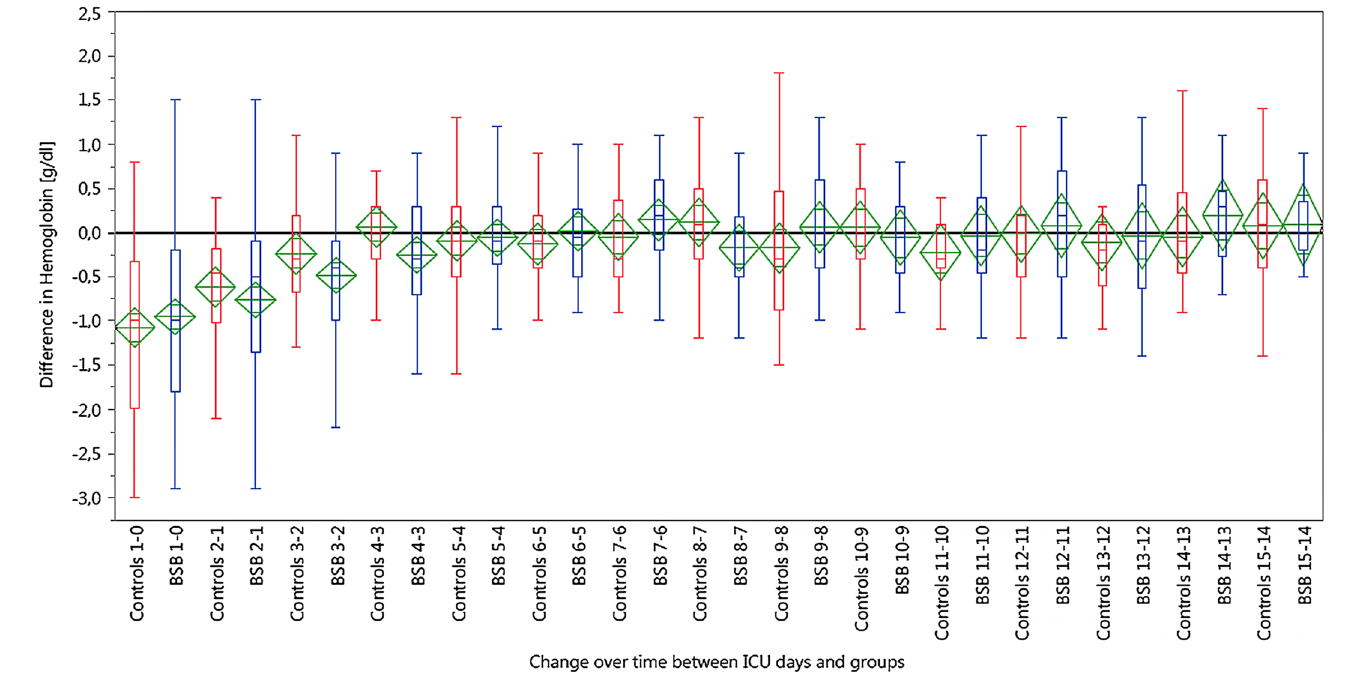
Fig 3. Box plots of the daily changes of the hemoglobin concentrations over time compared to the previous day in the control red) and in the BSB group (blue). (Note: The box shows the median with the 25th and 75th percentiles, and the whiskers indicate the minimum and maximum values. The mean diamonds (green) represent the mean and the 95% confidence interval of each group).